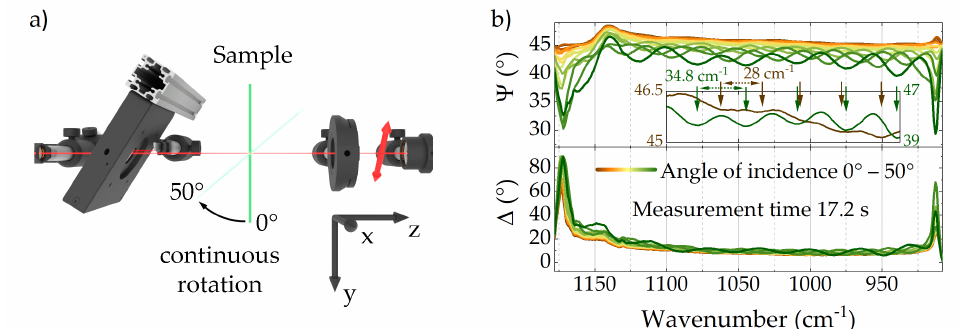
Figure 3. ( a ) Schematic of an IR-VASE measurement at continuously varying AOI. ( b ) ∆ , Ψ -spectra of a 116.5µm PE/EVOH/PE multilayer film recorded at continuously varying AOI. Frequencies of interference pattern for spectra at 0° (brown) and 50° AOI (green) are indicated in the inset.